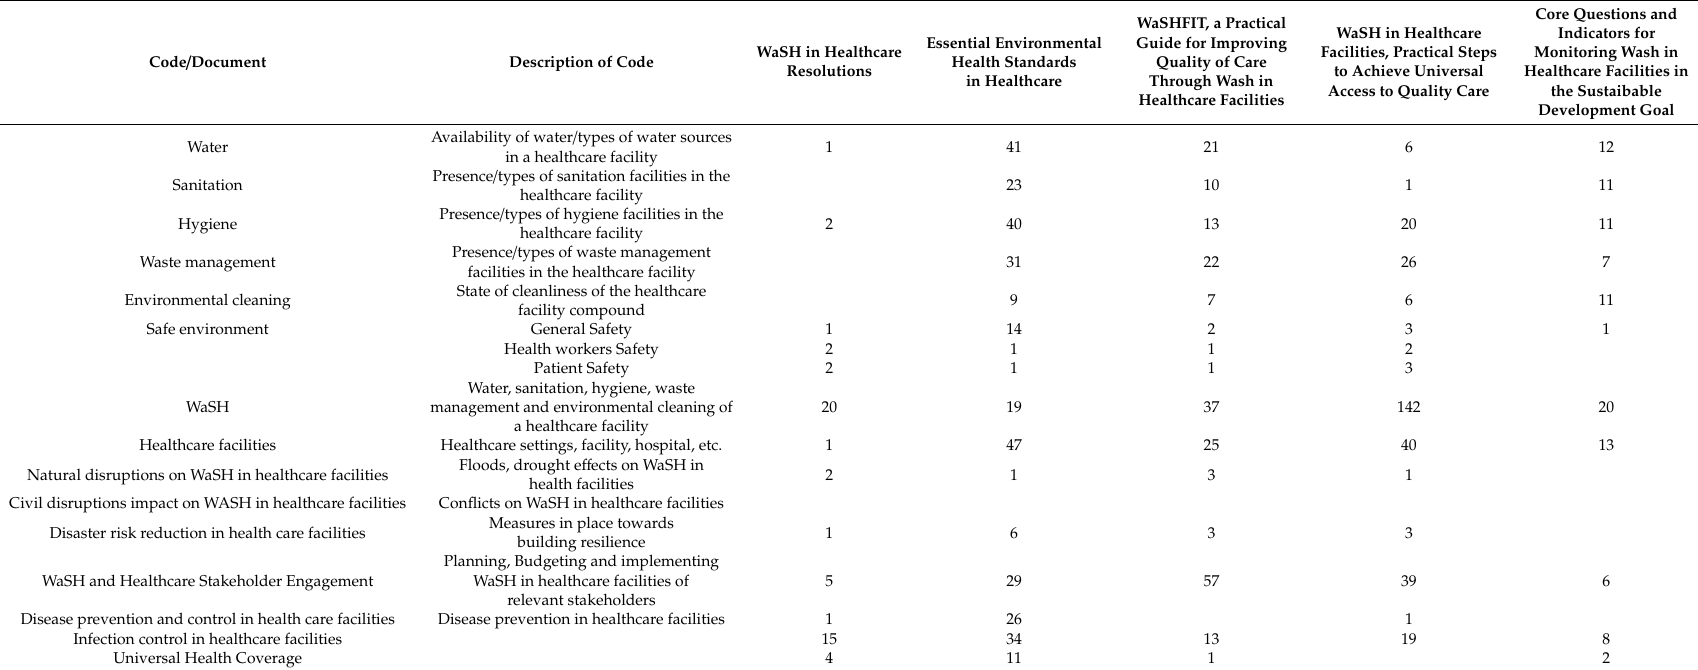
Table 3. Filled coding schedule for global-level